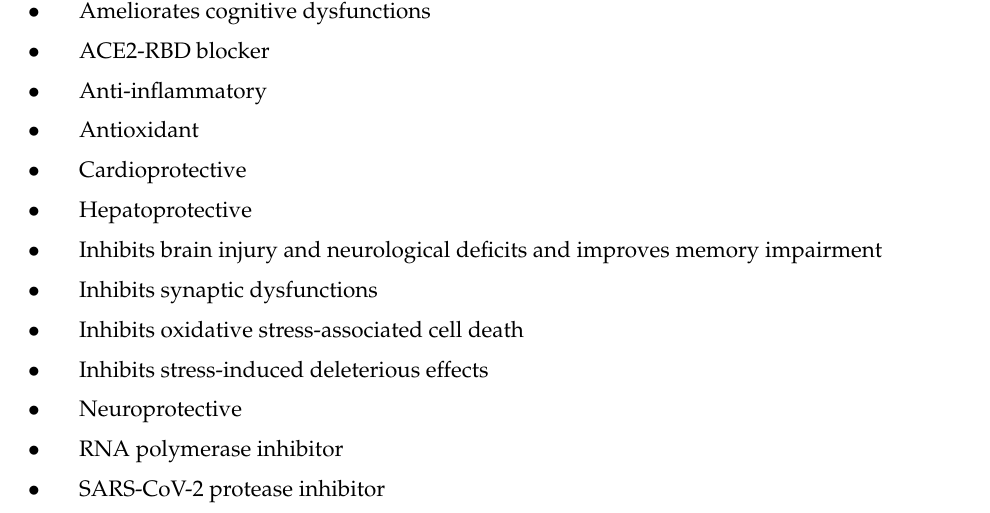
Table 2. Beneficial actions of